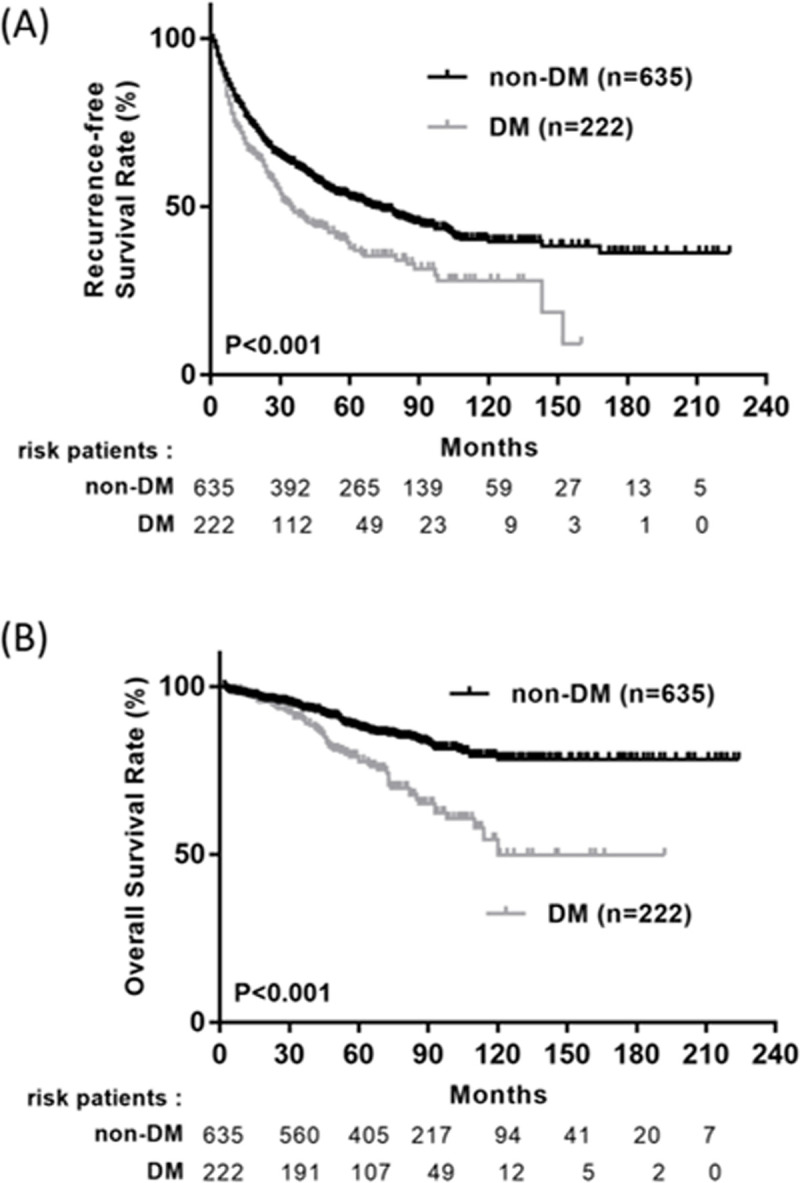
Long-term outcomes between patients with and without diabetes mellitus.(A) Recurrence-free survival; (B) Overall survival.